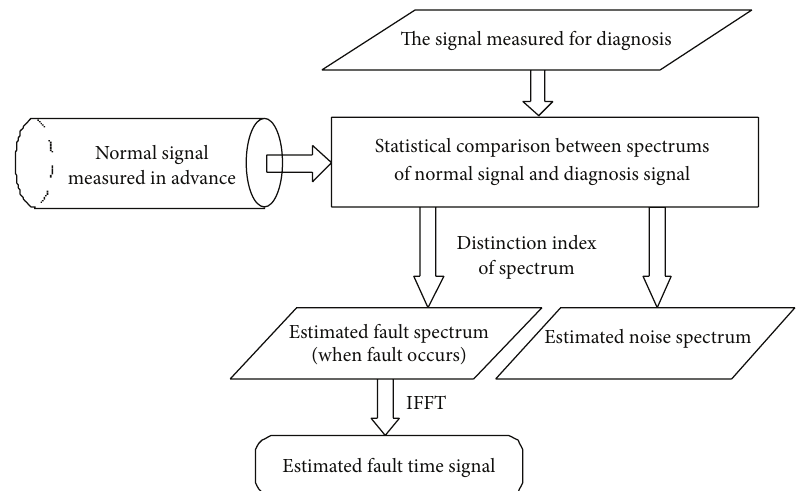
Figure 4: The principle of statistic filter based on distinction index (DI) of spectrums.